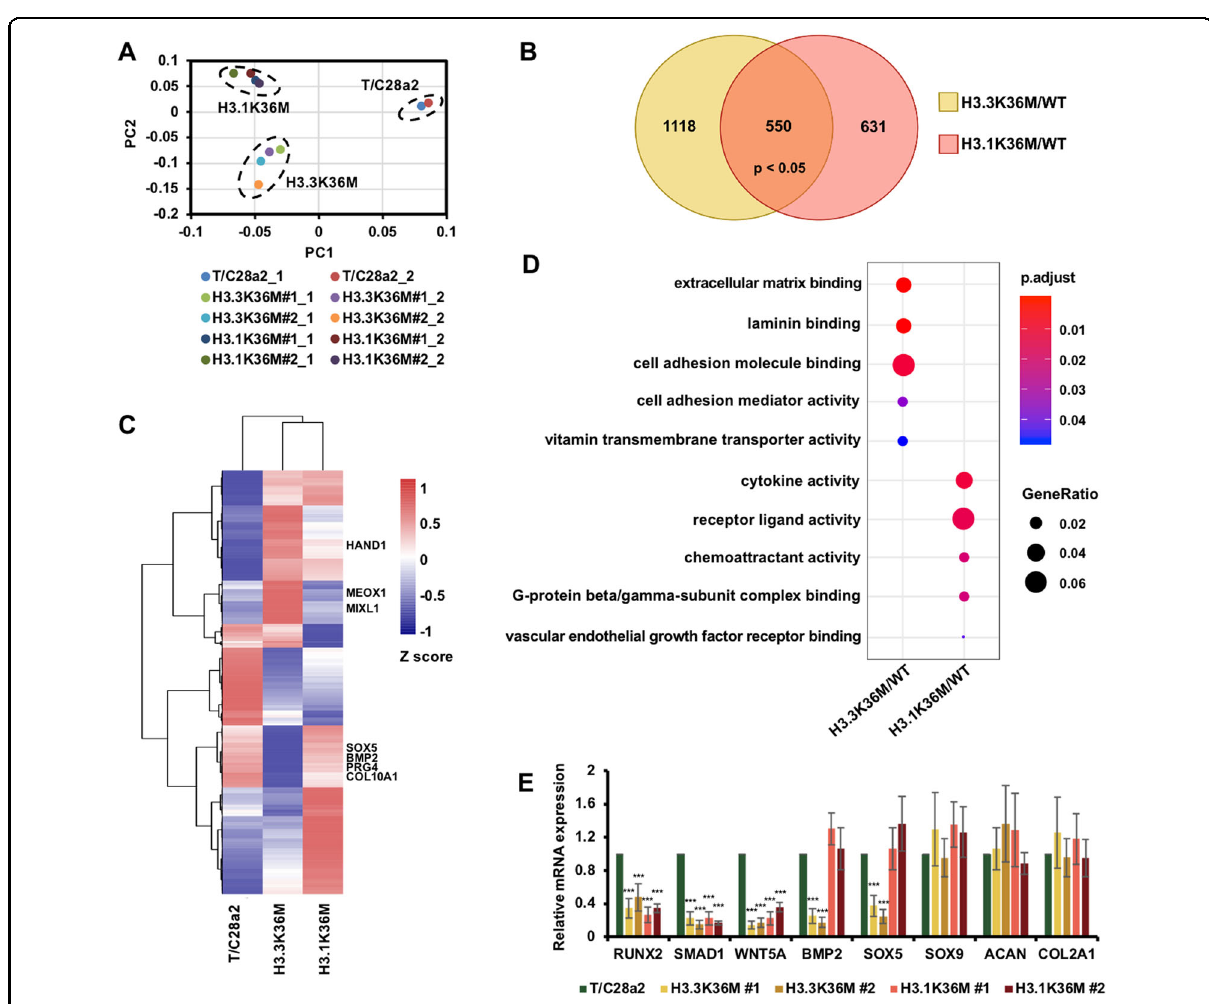
Fig. 2 H3.3K36M and H3.1K36M alter the expression levels of different sets of genes. A The principal component analysis (PCA) plot of the transcriptomic data from wild-type (WT), H3.3K36M, and H3.1K36M cells. The transcriptomic data from the independent clones of H3.3K36M- and H3.1K36M-mutant cells and two replicates were presented. B Venn diagram illustrating the overlap between the genes altered in the H3.3K36M- and H3.1K36M-mutant cells compared with their levels in WT cells. The RNA-seq data from two independent clones were merged to analyze differentially expressed genes. C Gene expression heatmap for wild-type, H3.3K36M, and H3.1K36M cells. All the changed genes between wild-type and H3K36M- mutant cells were collected for this clustering analysis. To represent the consistently changes of RNA-seq data, we fi rstly merged two replicates of each cell line and then merged the RNA-seq data of two independent clones of H3.3K36M and H3.1K36M. D The scatterplot shows the gene ontology (GO) analysis of the differentially expressed genes. The colors indicate the p value. The size was scaled according to the fractions of genes in the GO terms. E The expression levels of chondrogenic differentiation-related marker genes were analyzed via RT-PCR. The data are represented by the mean ± SD ( N = 3 independent replicates, *** p <